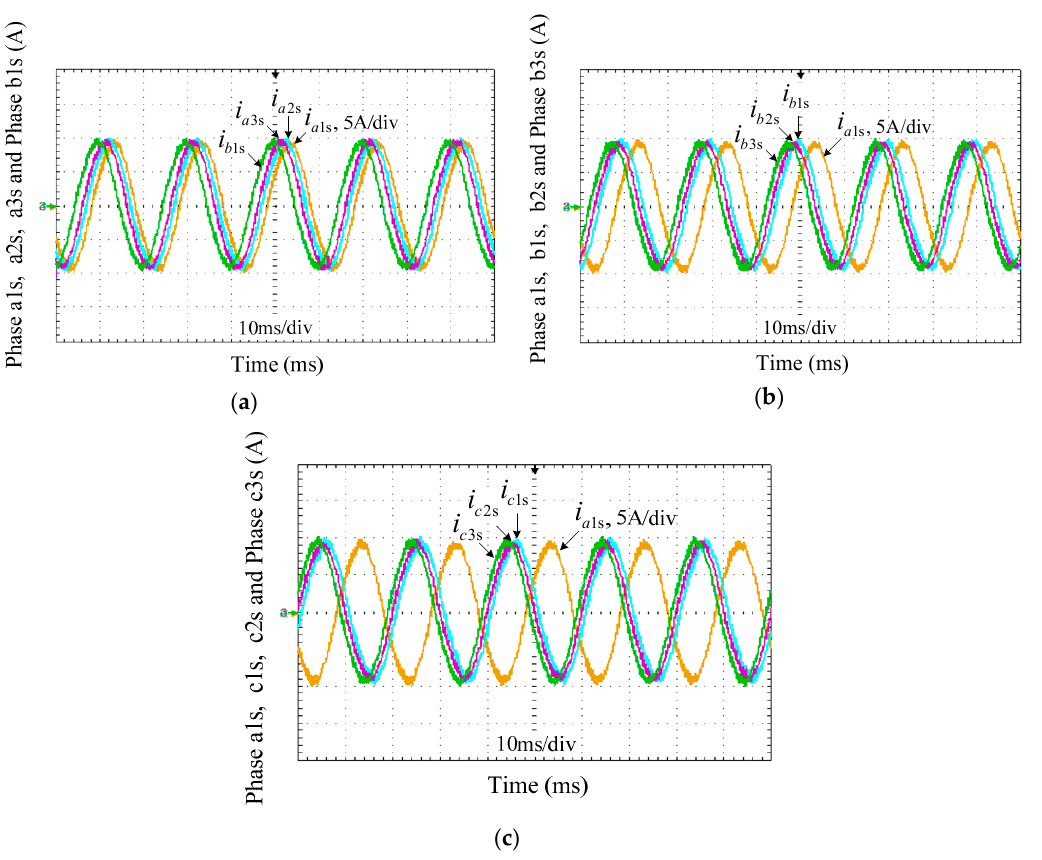
Figure 8. Stator winding currents of the motor in the steady ‐ state. ( a ) Phases a1s, a2s, a3s, and b1s; ( b ) Phases a1s, b1s, b2s, and b3s; ( c ) Phases a1s, c1s, c2s, and c3s. converter output voltage control. The steady ‐ state voltage and current waveforms of the drive converter are shown in Figure 9.